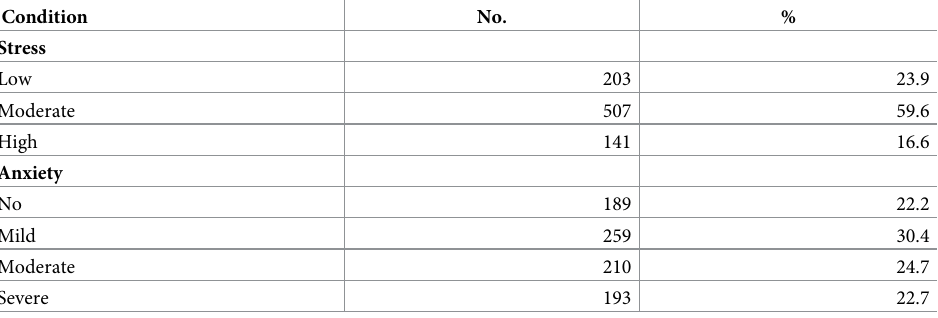
Table 2. Prevalence of different degrees of stress and anxiety among the